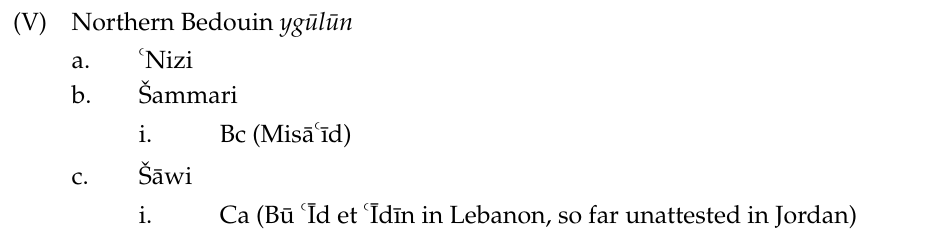
Table 1. Features of the Mis¯a “ ¯ıd and the Bedouin sub-groupings. A ( “ Niza ) B ( Šammar ) C ( š¯awi )